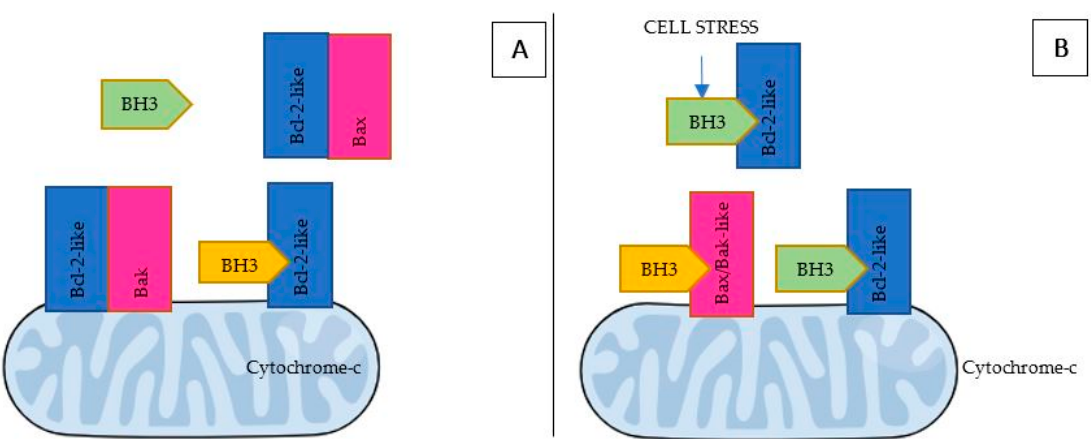
Figure 3. ( A ) Pro-apoptotic BH3 (only) or Bax/Bak-like proteins’ sequestration by anti-apoptotic Bcl-2-like proteins leads to cell survival. ( B ) BH3 (only)-proteins respond to cell stress provoked by chemo-therapeutic agents (Table 1) by binding to and inactivating anti-apoptotic Bcl-2-like proteins. BH3-only proteins can also engage Bax/Bak, causing their conformational transformation, activation and mitochondrial outer membrane destabilization [90].